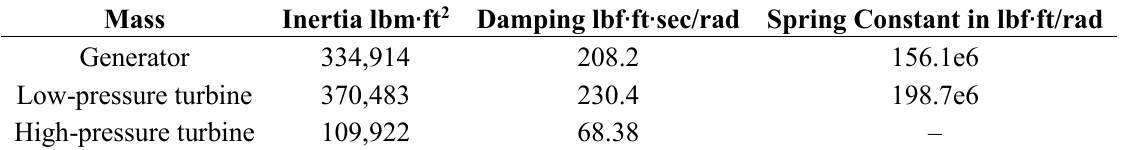
Table 2. Mechanical data for Generator B.